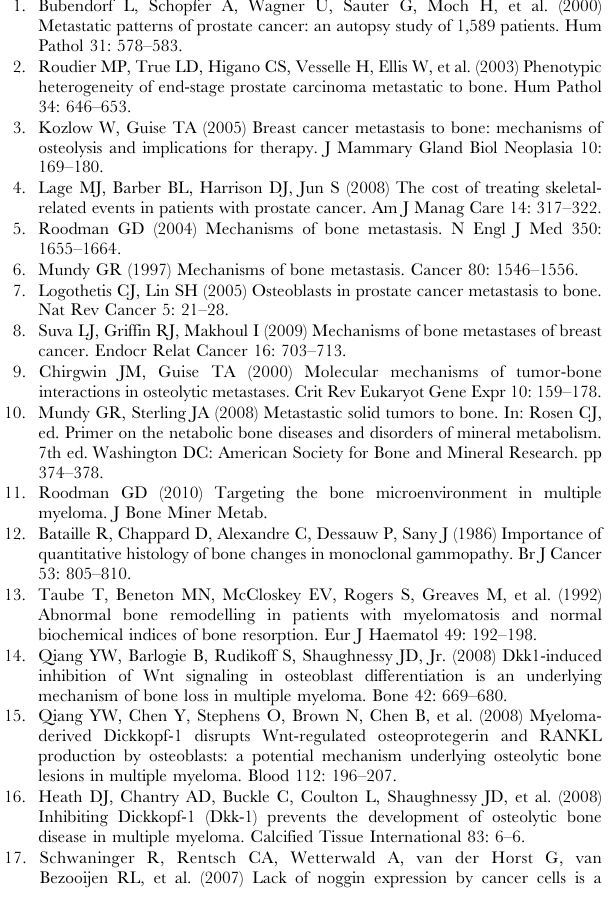
Table S1 The sequence of the different shRNA obtained from Superarray is shown.